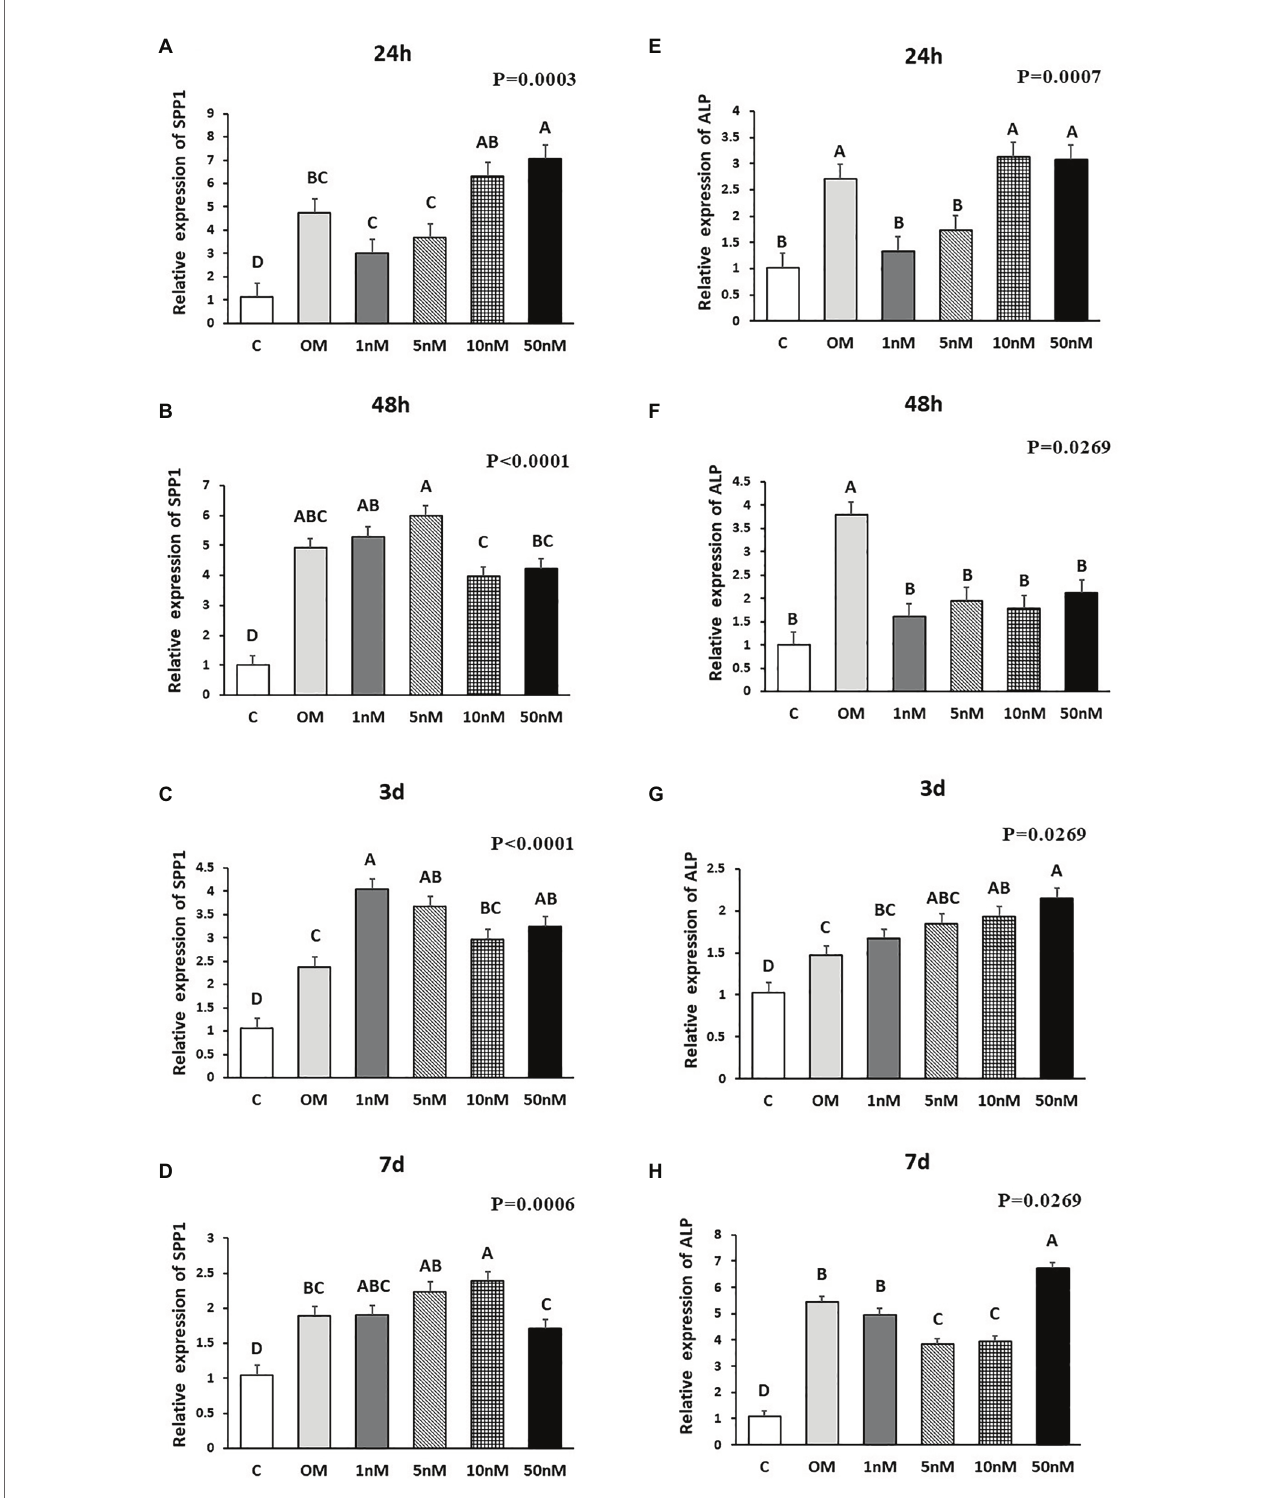
FIGURE 3 | Effects of 1,25OHD on chicken osteoblasts secreted phosphoprotein 1 (SPP1) and alkaline phosphatase (ALP) gene expression by using qRT-PCR. Cells were treated with control media, osteogenesis media, or osteogenesis media with 1, 5, 10, or 50 nM 1,25OHD. (A–D) showed the mRNA expression of SPP1 at 24 h, 48 h, 3 days, and 7 days, respectively; (E–H) showed the mRNA expression of ALP at 24 h, 48 h, 3 days, and 7 days, respectively. (A–D) Mean separation was indicated by different letters on the top of bars (Value means ± SEM, three